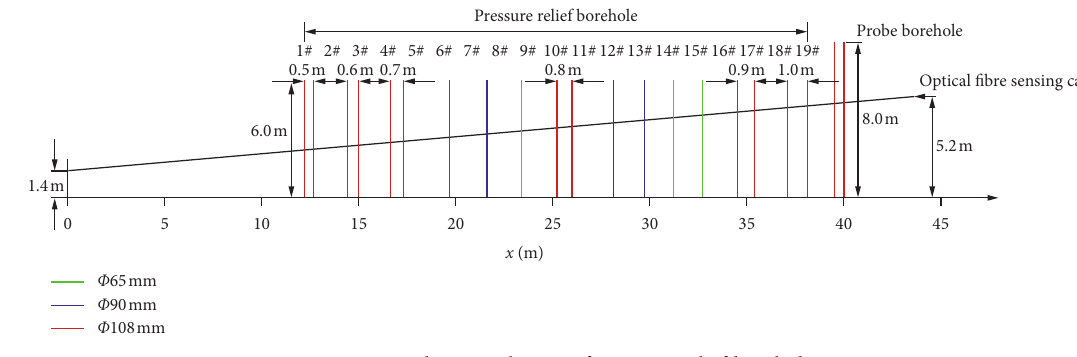
Figure 12: Plan view layout of pressure relief boreholes.